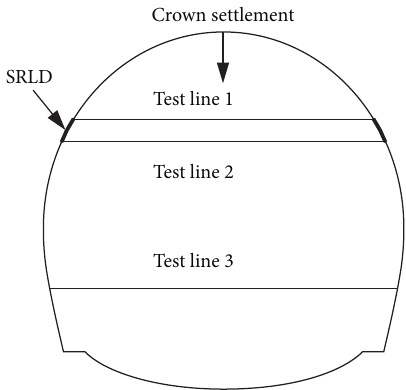
Figure 11: Diagram of crown settlement point and the horizontal convergence line.